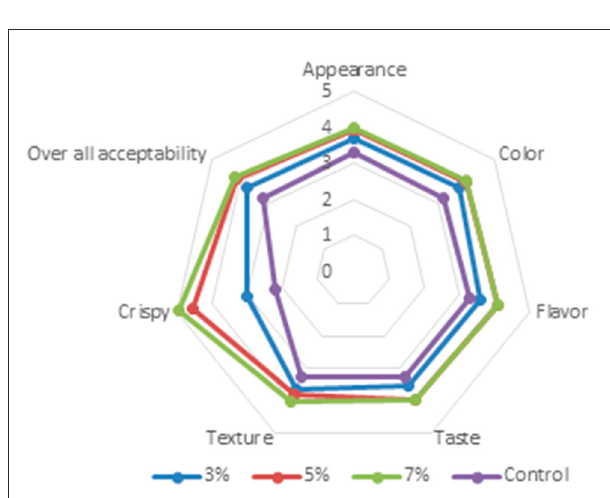
FIGURE2 Spider plot of the sensory-evaluation scores of different levels of orange albedo as coating films for deep-fried falafel balls.